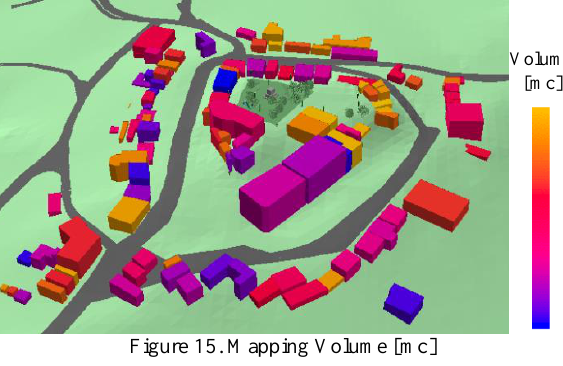
Figure 18. LOD1, mapping roof material